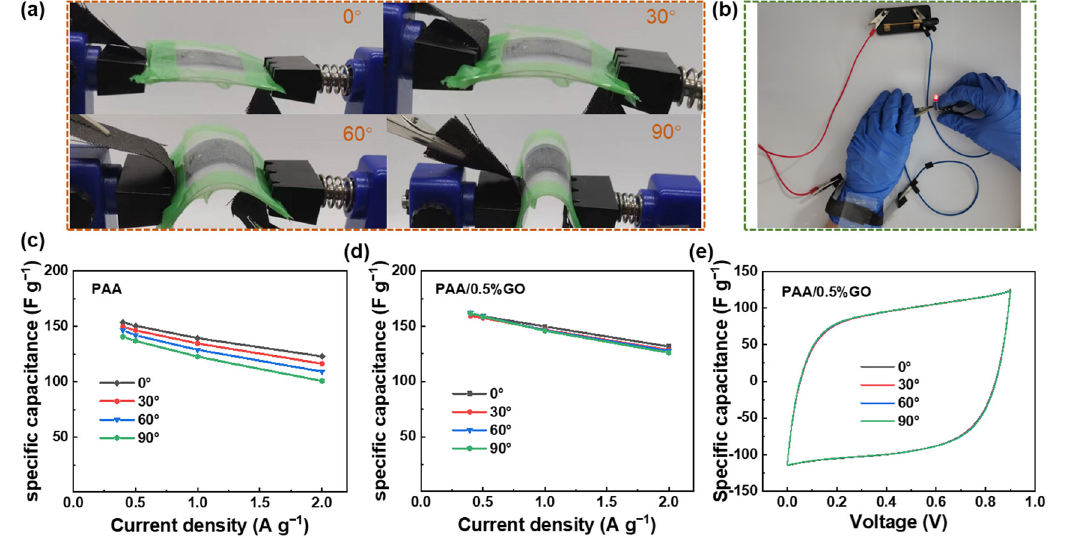
Figure 5. ( a ) Digital photographs of flexible supercapacitor tested at various bending angles of 0°, 30°, 60° and 90°. ( b ) Digital display of a small bulb lighted by three flexible supercapacitors connected in series. Rate performance for ( c ) PAA and ( d ) PAA/0.5%GO gel electrolyte at different bending angles. ( e ) CV curves at a scanning rate of 50 mV s − 1 for PAA/0.5%GO gel electrolyte at different bending angles.